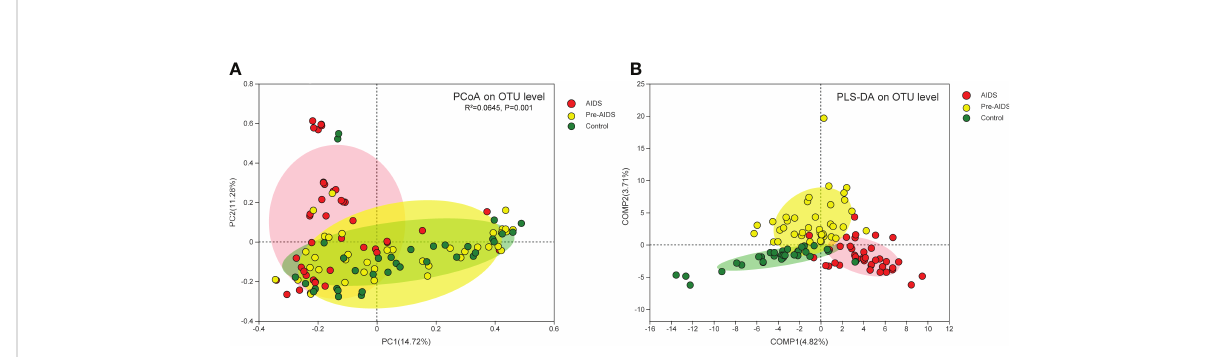
FIGURE 2 Composition of gut microbiota at different stages of HIV infection. (A) PCoA of Bray-Curtis dissimilarity of microbiota revealed that gut microbiota was separated by different stages of HIV infection, and a statistically signi fi cant difference was observed in the PERMANOVAR ( P =0.001); (B) PLS-DA showed that gut microbiota at different stages of HIV infection clustered into three distinct clusters. Each dot refers to a sample. Red dot, yellow dot and green dot represent AIDS group, pre-AIDS group and healthy control group respectively.